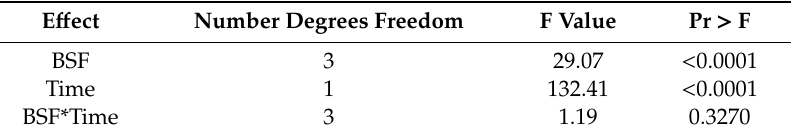
Table 5. Test of fixed effects of E. coli.